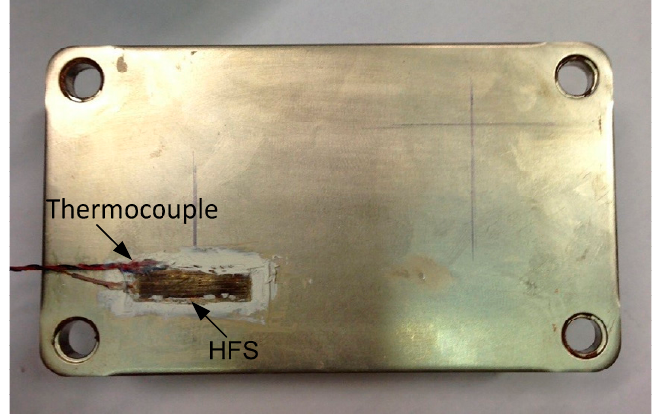
Figure 9. Attachment of the sensor to the base plate.